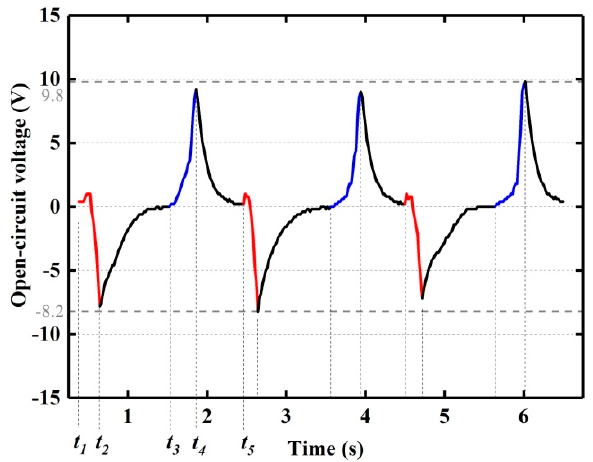
Figure 6. The open-circuit voltage during the foot strikes.